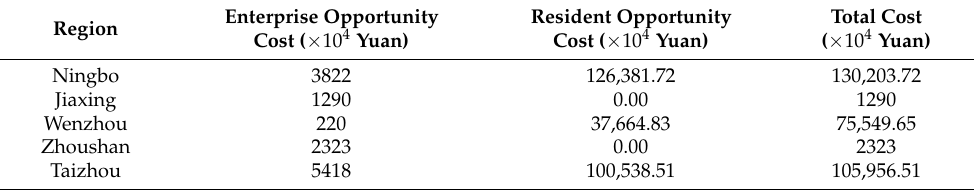
Table 2. Indirect cost of the coastline ecological restoration project in five coastal cities of